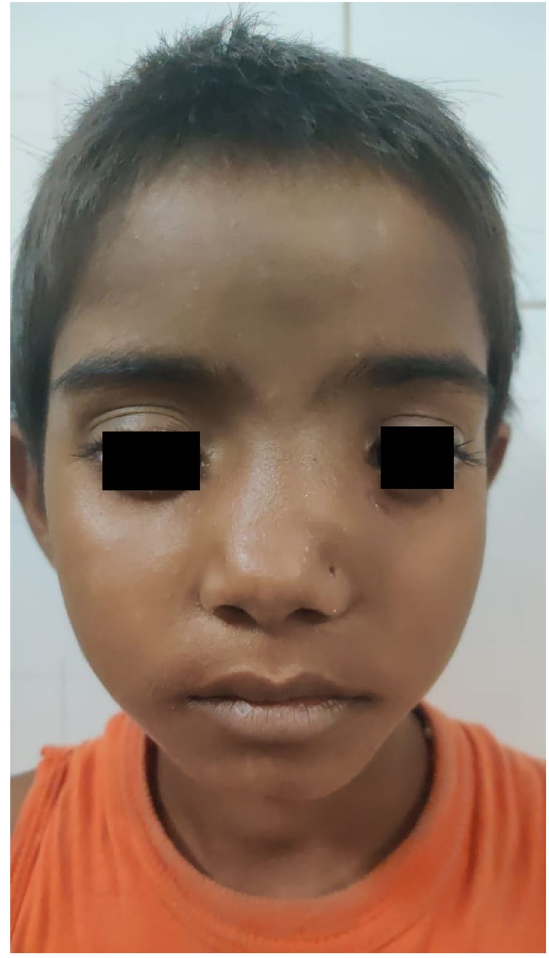
Fig. 2 Pre-op image of the patient showing swelling over left side of nasal cavity and cheek with broadening of nasal